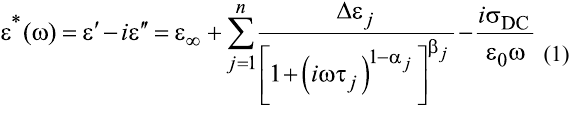
the bent-core nematic phase was previously observed in